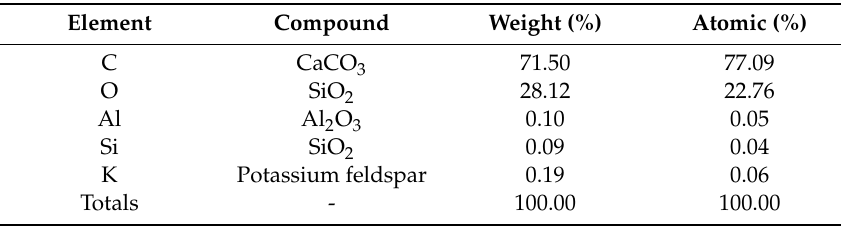
Figure 5. Energy Dispersive X-Ray (EDX) analysis of cassava peel.